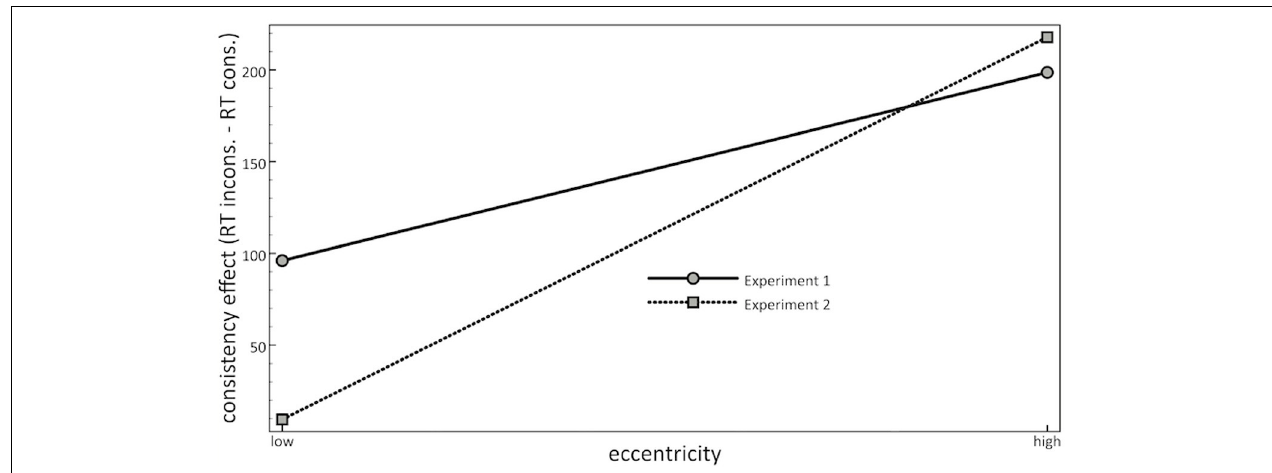
FIGURE 4 | Mean consistency effects in Reaction Times (RTs), calculated as RT of responses to inconsistent objects minus RT of responses to consistent objects, as a function of eccentricity (from